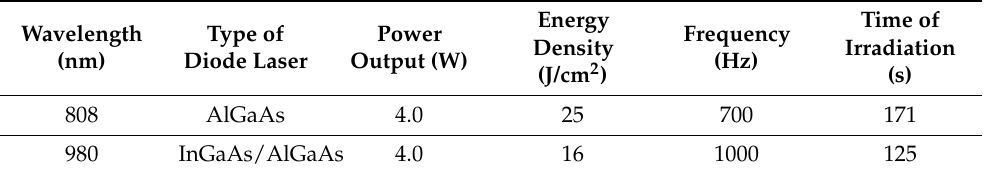
Table 1. High-intensity laser therapy parameters for treatment of the superficial digital flexor tendon of the hindlimb.